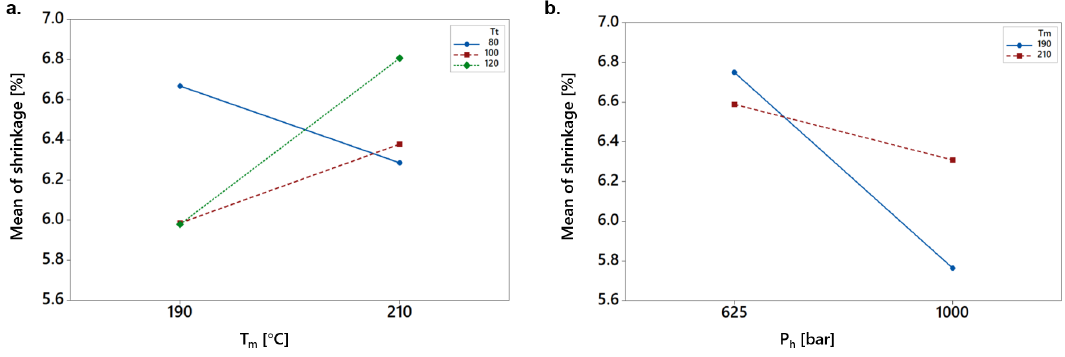
Figure 10. Interaction plots for shrinkage between packing pressure and melt temperature ( a ) and melt temperature and mold temperature ( b